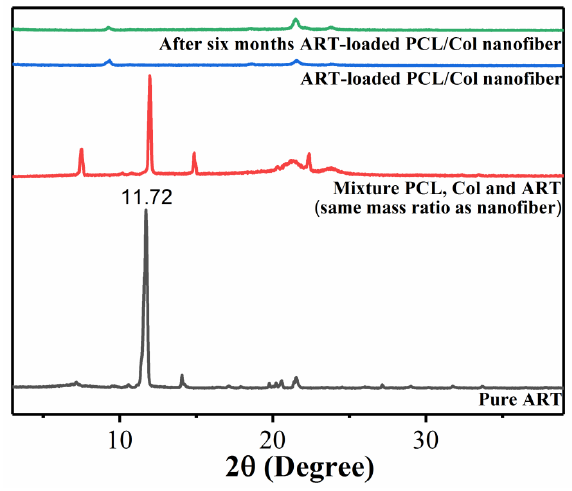
Figure 2. XRD patterns of neat ART, physically mixed ART/PCL/Col, ART-loaded PCL/Col nanofibers, and ART-loaded PCL/Col nanofibers after six months of storage.